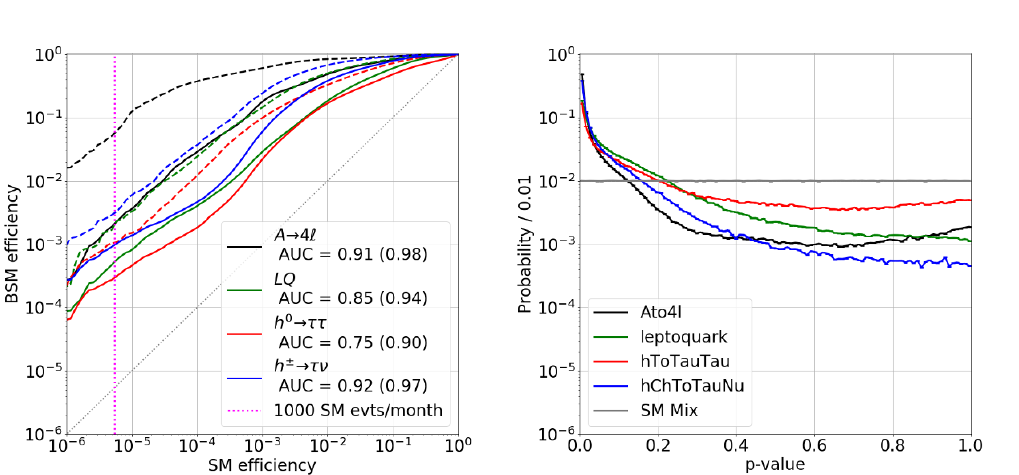
Figure 10 . Left: ROC curves for the VAE trained only on SM events (solid), compared to the corresponding curves for the four supervised BDT models (dashed) described in section 4.2. Right: normalized p-value distribution distribution for the SM cocktail events and the four BSM benchmark